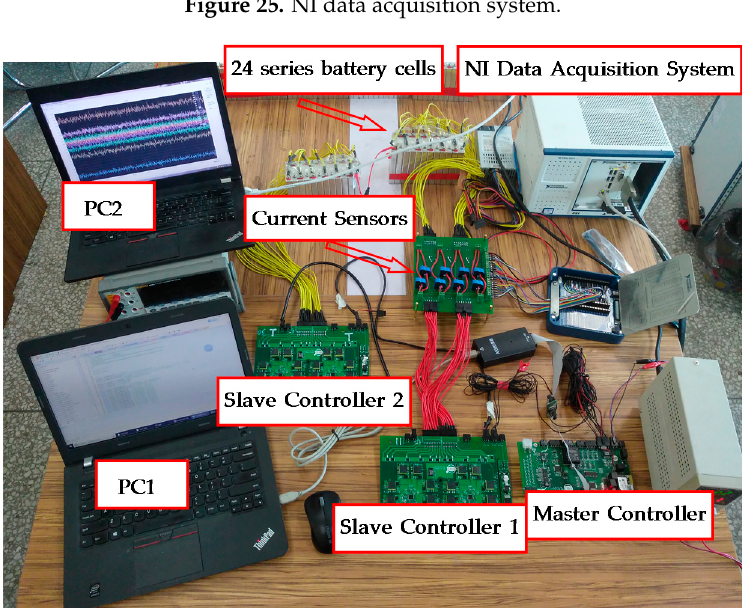
Energies 2018 , 11 , x FOR PEER REVIEW